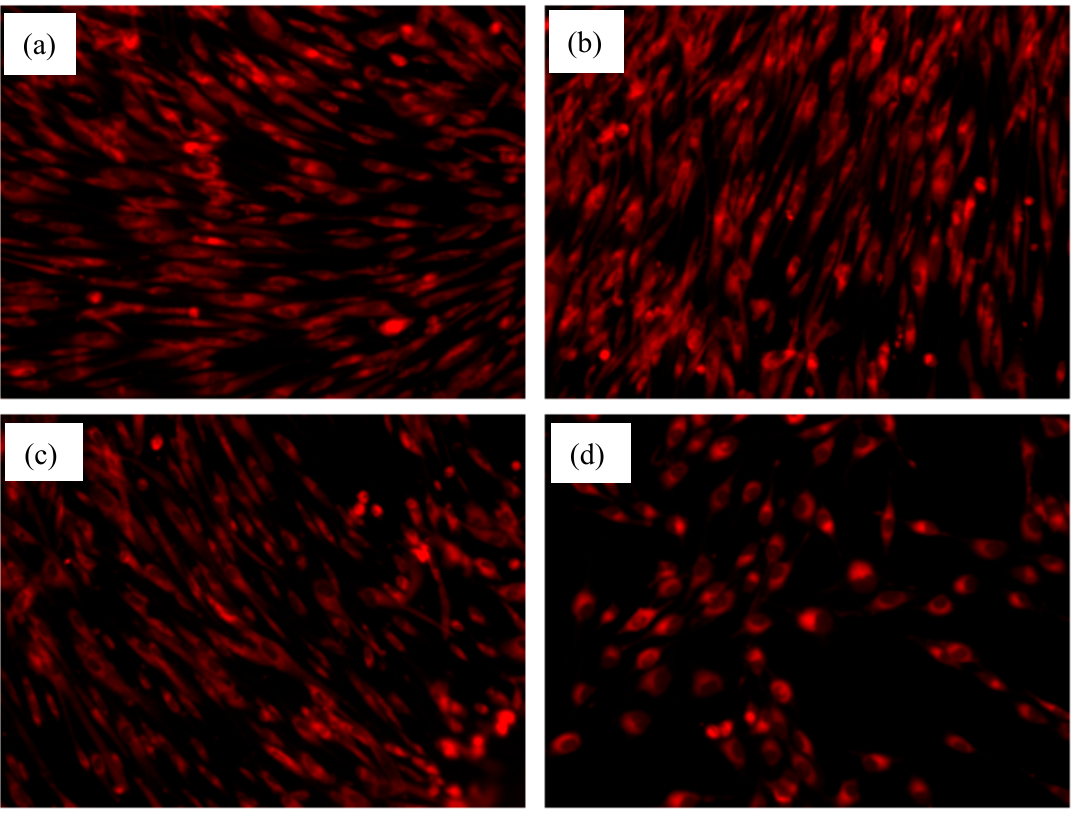
Figure 14. Fluorescence microscopy images of the AFSC interaction with: ( a ) CS, ( b ) CS_Gel, ( c ) HAp(ESM)_CS_Gel_BA, and ( d ) control sample.